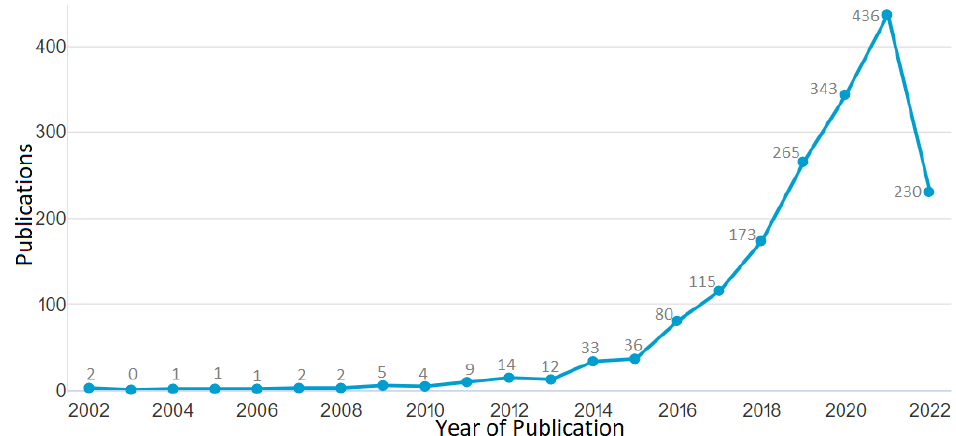
Figure 6. The number of publications against years of publication for publications from 2002 to 2022 (data retrieved from the Scopus database on 20 June 2022).